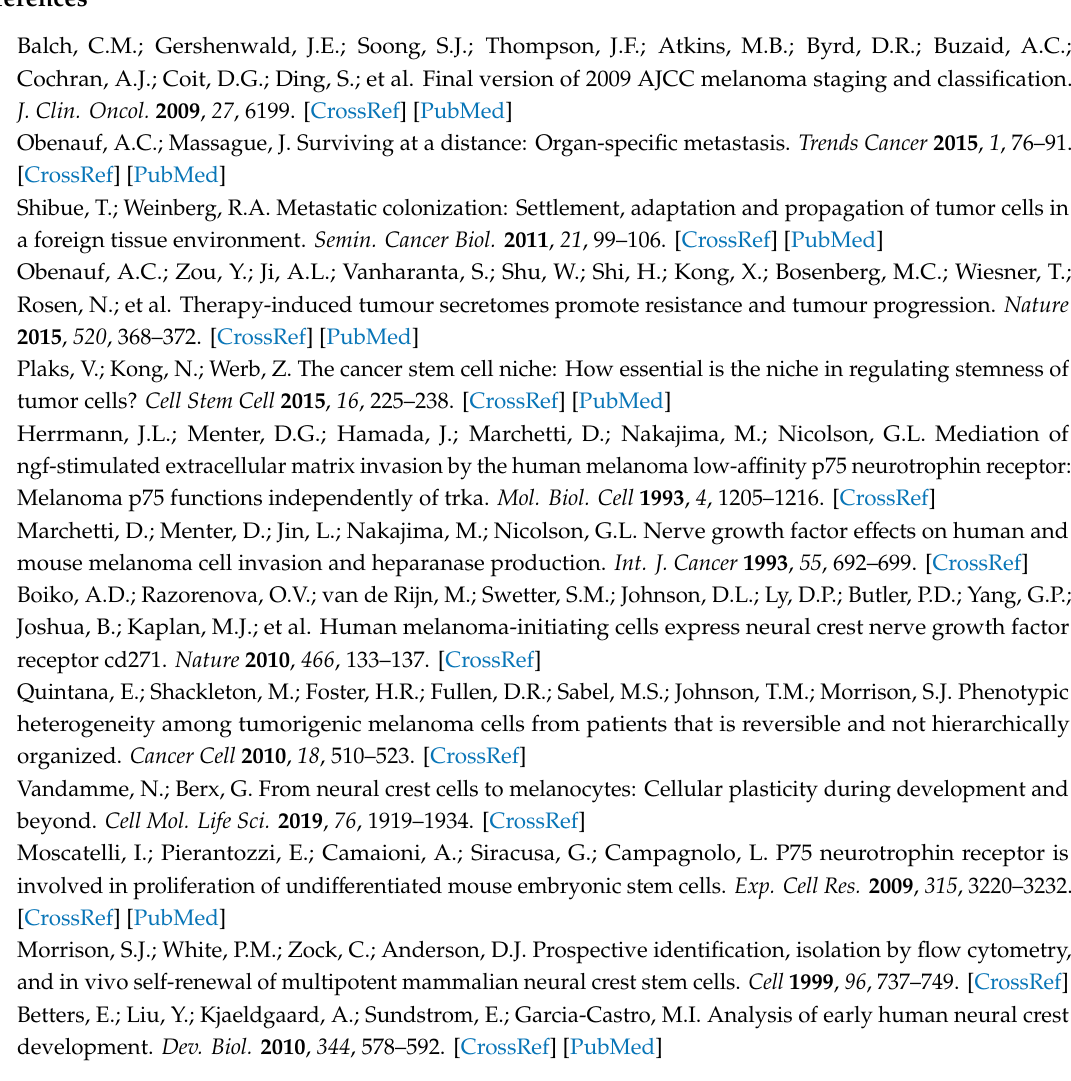
Figure S1. The evolution of melanocytes; Figure S2. Expression of CD271 in skin and skin cancer; Figure S3. Molecular programs defining the transformation of melanocytes to metastatic melanoma; Figure S4. Chemotherapeutic drugs increase the expression CD271; Figure S5. The expression of CD271 is su ffi cient for sub-clustering melanoma brain metastases; Figure S6. Phenotypical heterogeneity of melanoma; Figure S7. CD271 in cancer; Table S1. CD271 in other cancer